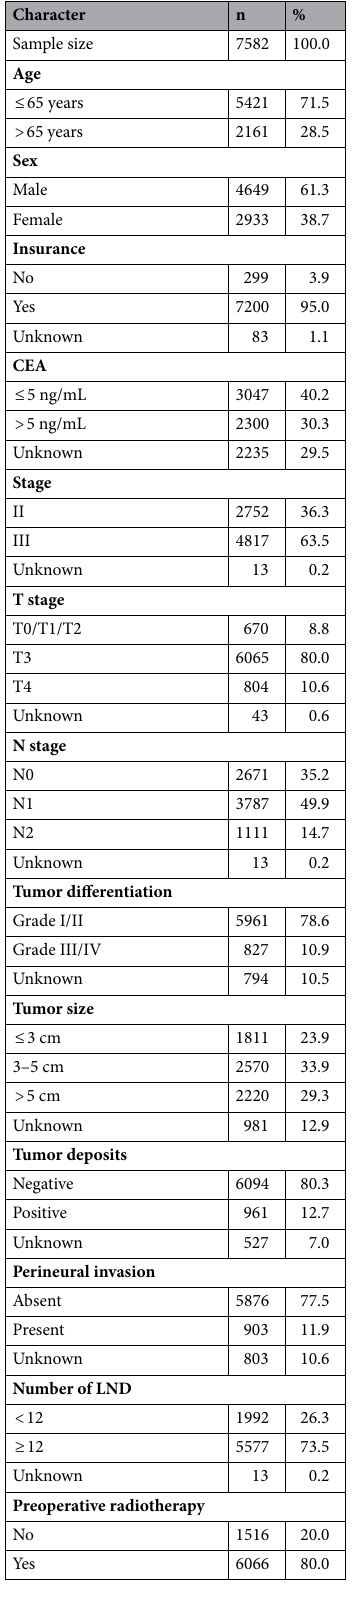
Table 1. Demographic and tumor characteristics of 7582 rectal cancer patients. CEA carcinoembryonic antigen, LND dissected lymph